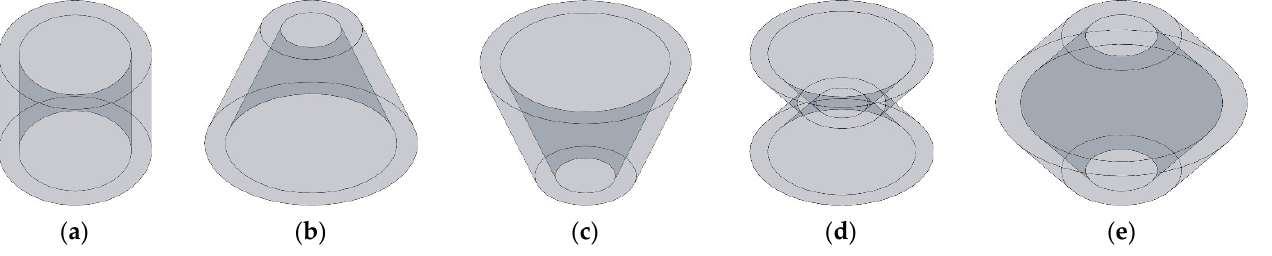
Figure 1. The three-dimensional structures of apertures for various tangent sectional shapes. ( a ) Rectangle; ( b ) common trapeziform; ( c ) reverse trapeziform; ( d ) dumbbell; and ( e ) olive. Each aperture includes a solid wall and air domain, and the tangent sectional shape of air domain is shown in Figure 2. Here R u , R m and R l are the radiuses of upper plane, middle plane and lower plane respectively. It can be observed that the tangent sectional shapes are the rectangle, common trapeziform, reverse trapeziform, dumbbell and olive. That is the basis for naming the HR with embedded aperture for various tangent sectional shapes. The aperture for each tangent sectional shape is rotational symmetric, so the two-dimensional symmetric finite element simulation model can be applied to study the sound absorption performance of HRs with the aperture for various tangent sectional shapes. It is favorable to reduce the simulation time and improve the simulation efficiency simultaneously.